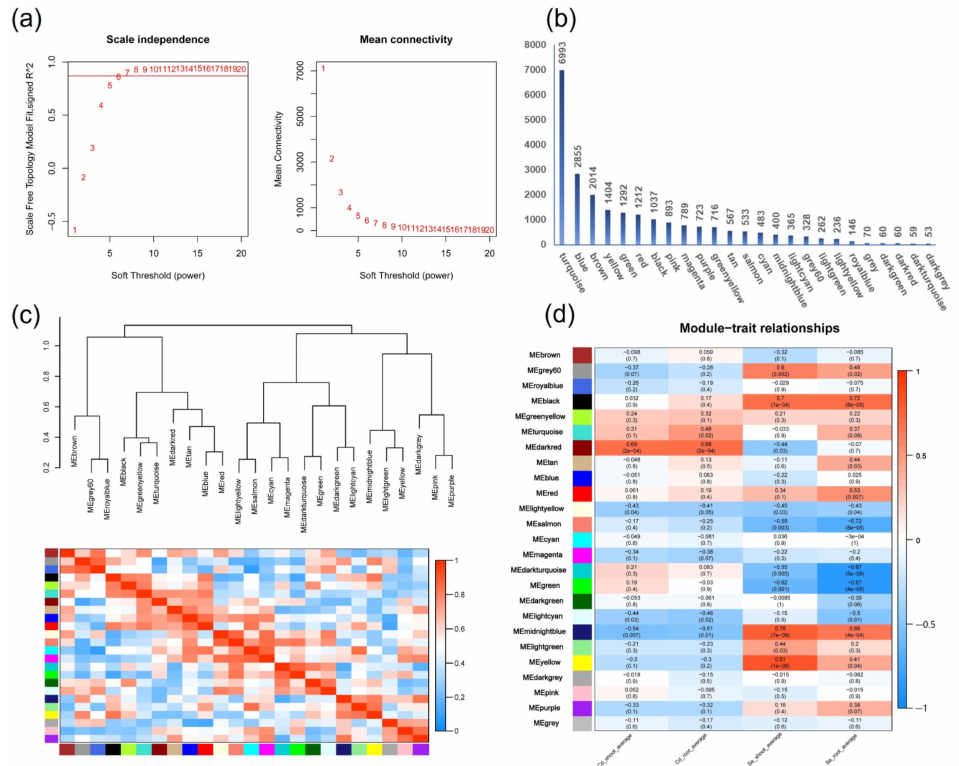
Figure 10. WGCNA analysis of the relationships between the aboveground and underground distribution of Cd and Se and the characteristics of transcriptome data of different treatment groups. ( a ) The scale-free network fitting index (R 2 ) under different soft thresholds; the red line represents R 2 = 0.75. The average connectivity under different soft thresholds. ( b ) The distribution and quantity of DEGs in different modules. ( c ) The WGCNA is constructed using a dynamic tree-cutting method, and different modules are marked with different colors. ( d ) The correlation between modules and